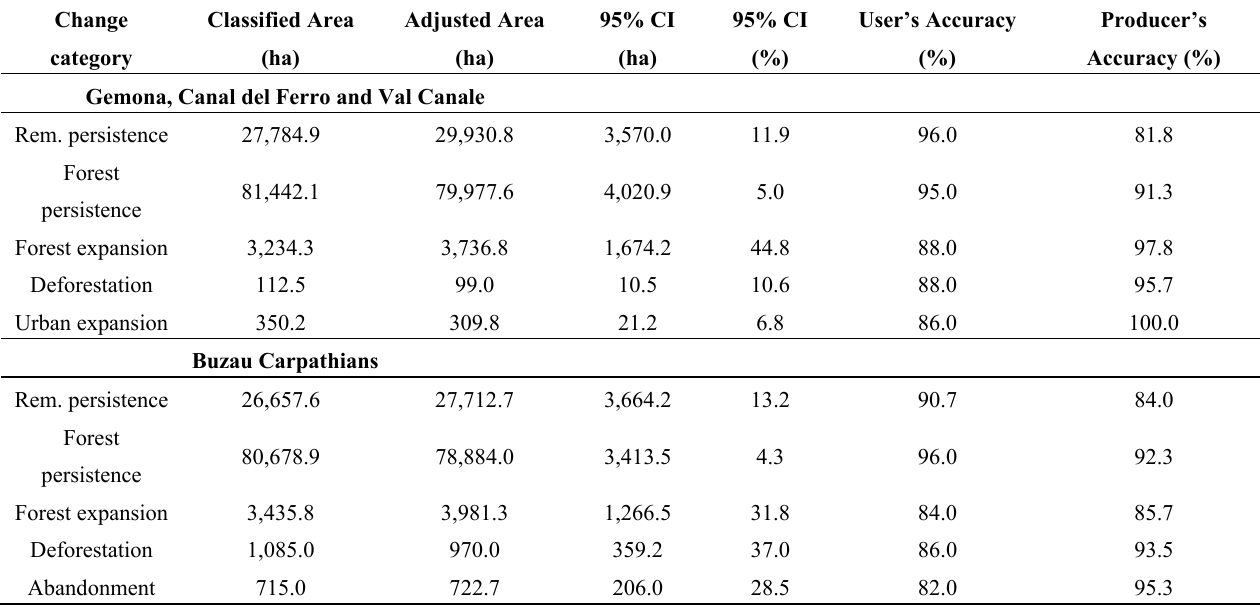
Table 6. Accuracy assessment and estimation of areas with a margin of error at a 95% confidence interval for both land cover change maps (Figure 3). CI, confidence